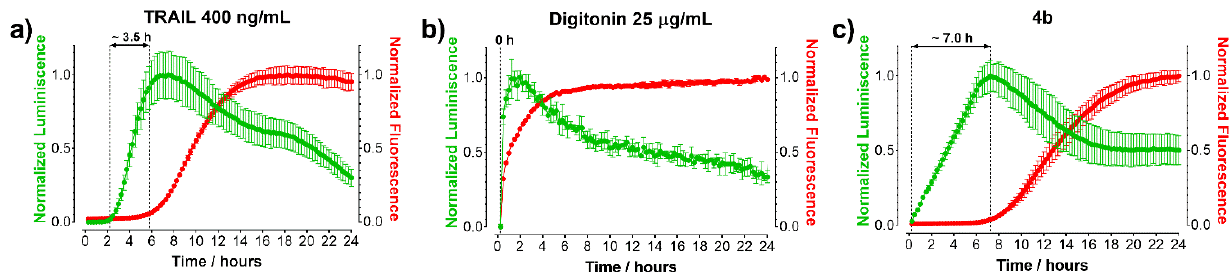
Figure 4. Cell death determination. Annexin V (green) and DNA-binding probe (red) binding profiles for TRAIL (( a ) apoptosis control), digitonin (( b ) necrosis control), and 4b at EC 85 ( c ).